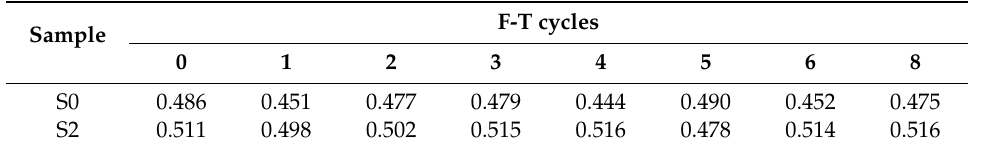
Table 4. C under F-T cycles.